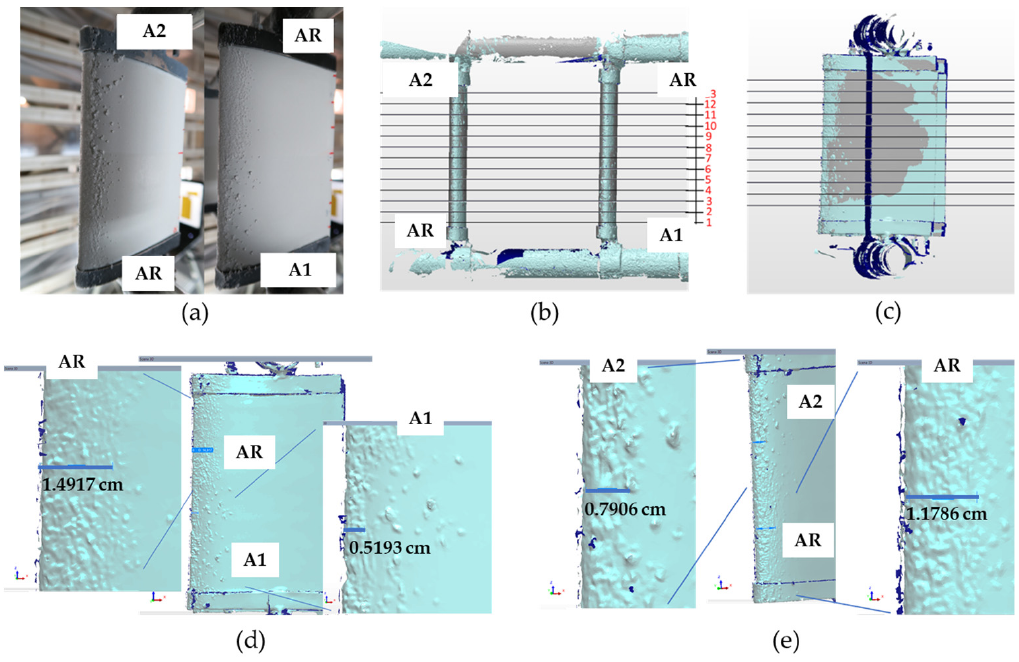
Figure 17. ( a ) Pictures of samples after test 6; ( b , c ) front and side view of slices where the ice contour was extracted; ( d , e ) 3D scan of A1 and A2 samples after test 6. Table 4. Comparison between Lci values measured experimentally and through 3D scan (test 6).